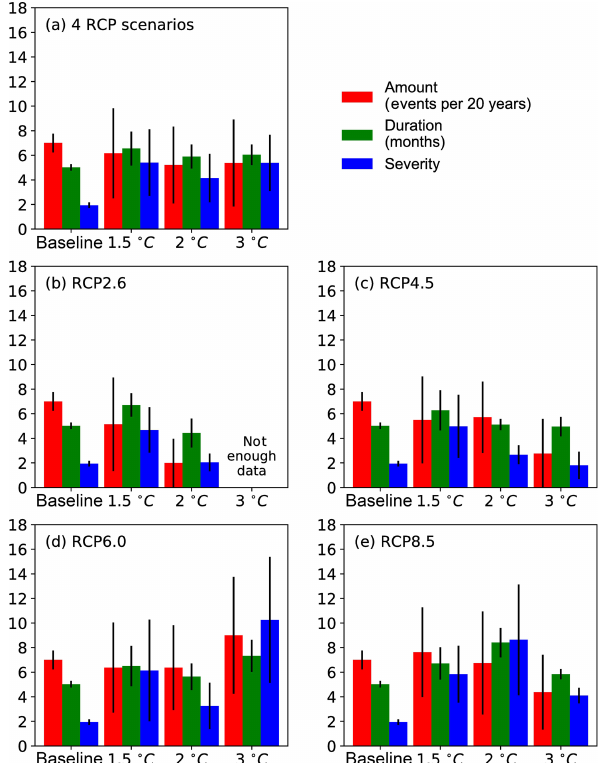
Figure 6. Comparison of the characteristics (amount: number of drought events per 20 years; duration: months; and severity) aver- aged among climate models and RCP scenarios for hydrological drought events during the baseline period (1986–2005) and the pe- riods reaching 1.5, 2 and 3 ◦ C warming levels. Black lines indicate 5%–95% confidence intervals.